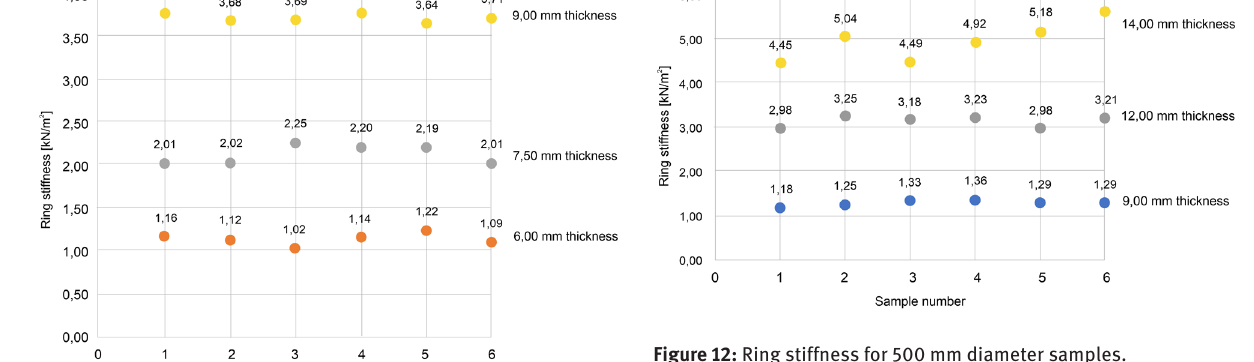
Figure 12: Ring stiffness for 500 mm diameter